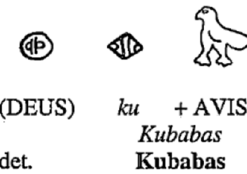
Figure 11. The Hieroglyphic Luwian writing for the goddess Kubaba (from Payne 2010, p. 74).